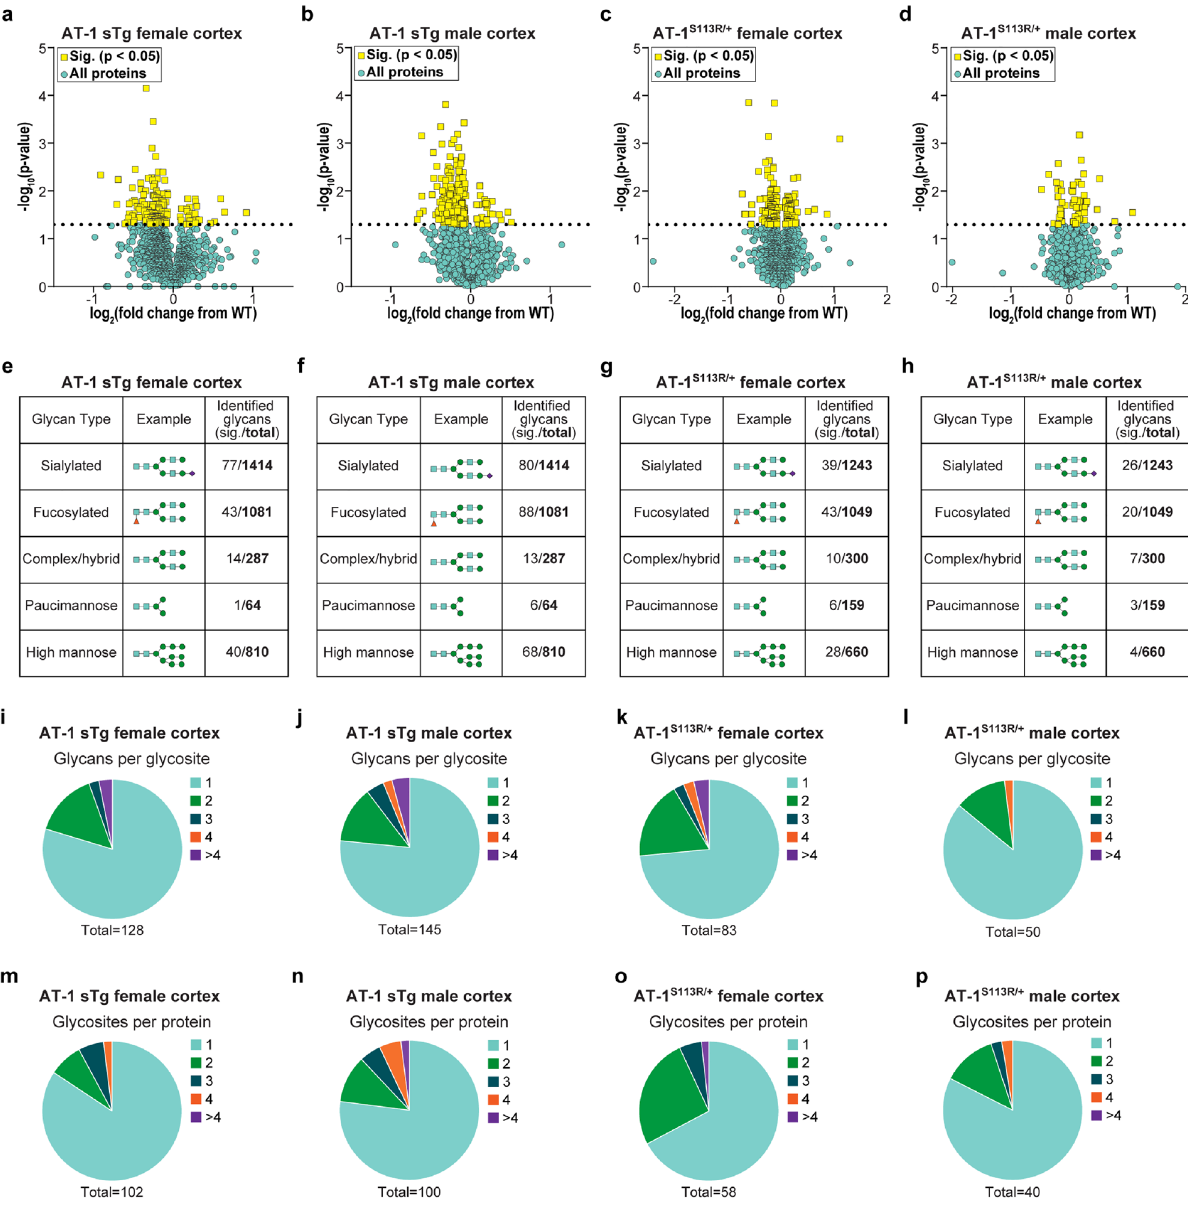
To understand the biological relevance of the changes observed within the entire secretome, all glycoforms were categorized into subcellular locations based on their GO Cellular Compartment terms. Across both AT-1 models and sexes, the subcellular locations which showed the greatest changes include vesicle, extracellular space, neural, and plasma membrane (Fig. 5e–h). Similar results were observed in the hippocampus (Supplementary